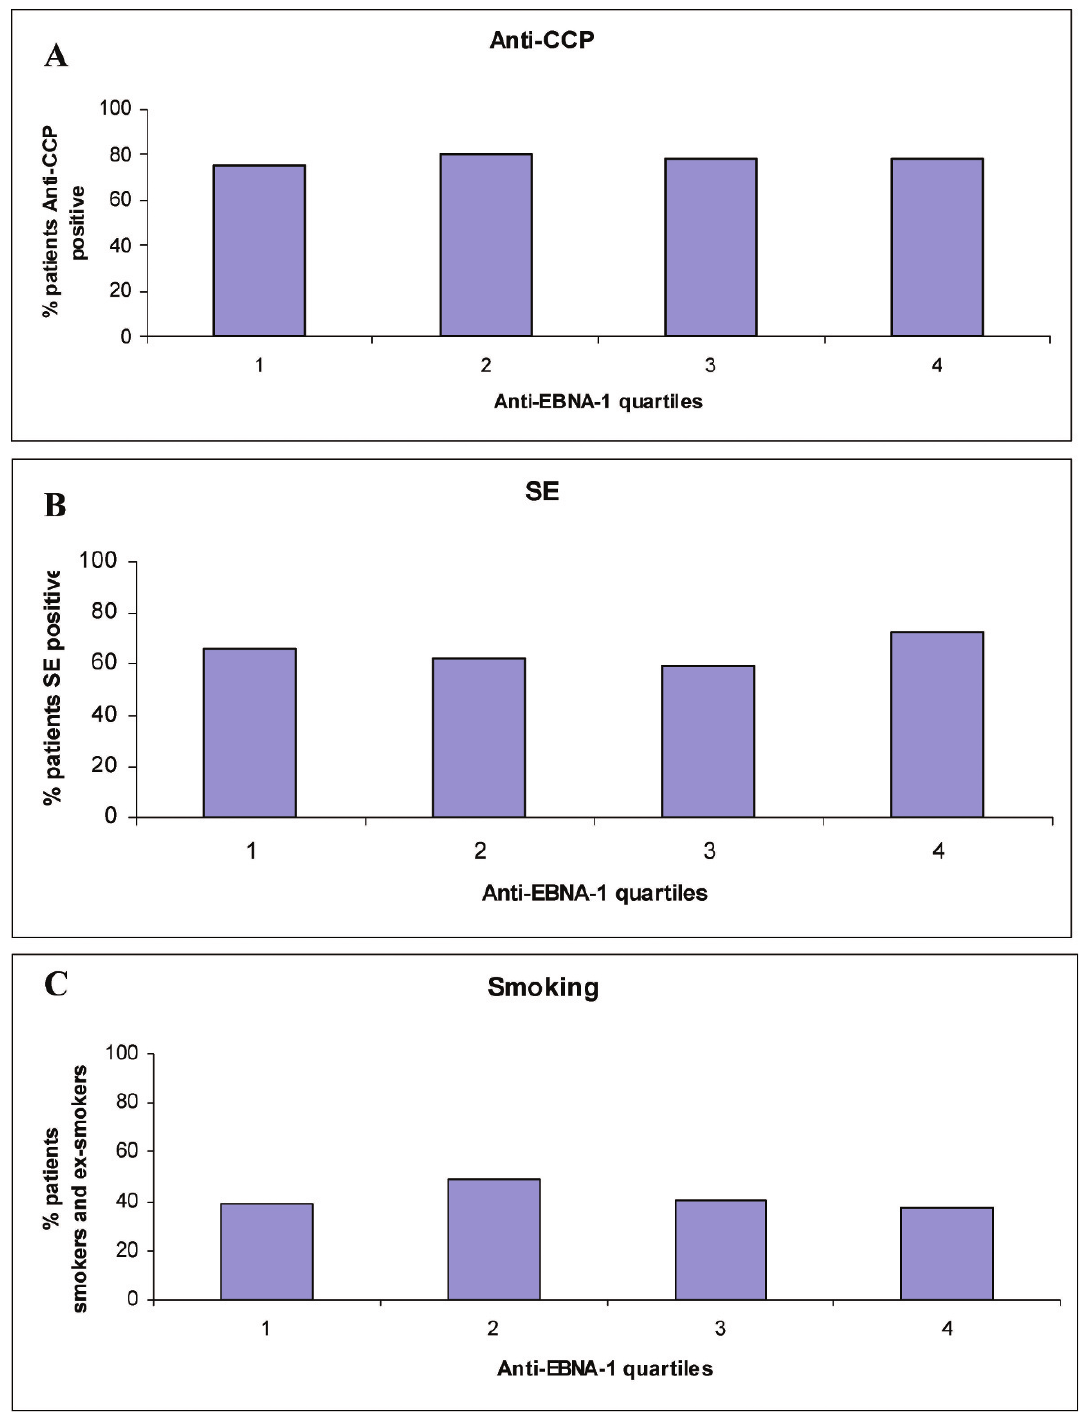
Figure 1 - Anti-EBNA-1 profiles in RA patients. A - profile according to anti-CCP ( p =0.98); B - profile according to SE status ( p =0.96); C - profile according to smoking status (